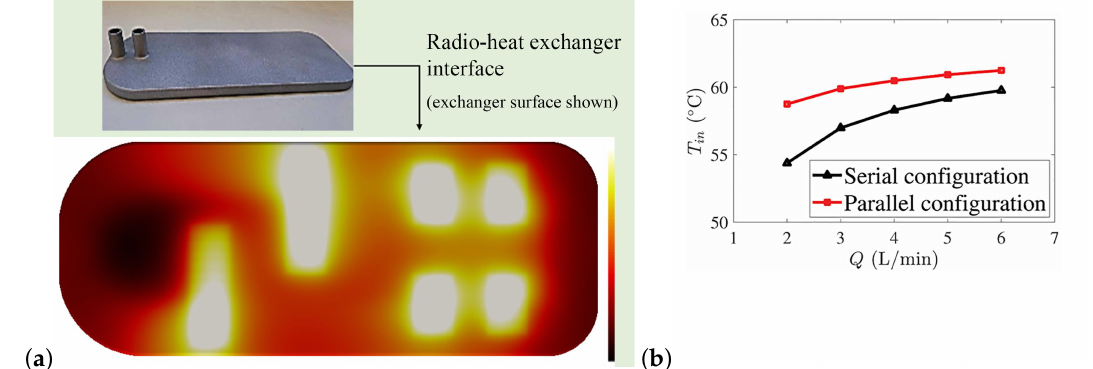
Figure 13. CFD analysis of a 3D printed heat exchanger and the cooling strategy: ( a ) simulated heat exchanger (outside) surface temperature (color range represents ∆ T = 10 ◦ C) when water flows into and out from a 3D printed heat exchanger via embedded rows of channels; ( b ) the highest allowed inlet temperature as a function of mass flow rate to maintain below 65 ◦ C surface temperatures per cooling